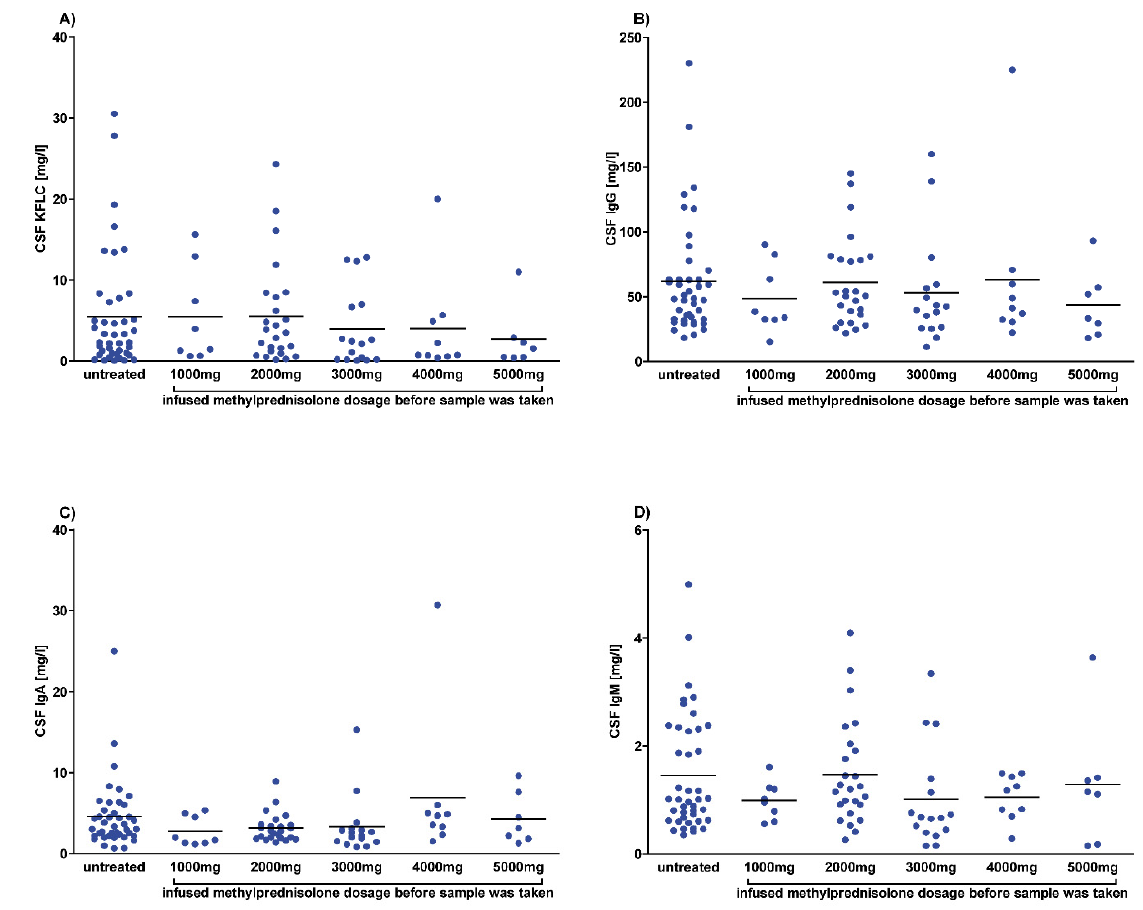
Figure 2. Cerebrospinal fluid (CSF) concentrations after methylprednisolone. CSF concentrations of patients diagnosed with multiple sclerosis according to the McDonald criteria of 2017 and clinically isolated syndrome who converted to multiple sclerosis during follow-up. Each dot represents a single measurement of a patient who was untreated or received intravenous methylprednisolone with the indicated dose. Depicted are CSF concentrations of kappa free light chains (KFLC) ( A ), immunoglobulin type G (IgG) ( B ), IgA ( C ), and IgM ( D ) in untreated patients (n = 42) and patients who received methylprednisolone infusion of 1000 mg (n = 8), 2000 mg (n = 25), 3000 mg (n = 16), 4000 mg (n = 9), or 5000 mg (n = 7). p -values of significant di ff erences are illustrated as